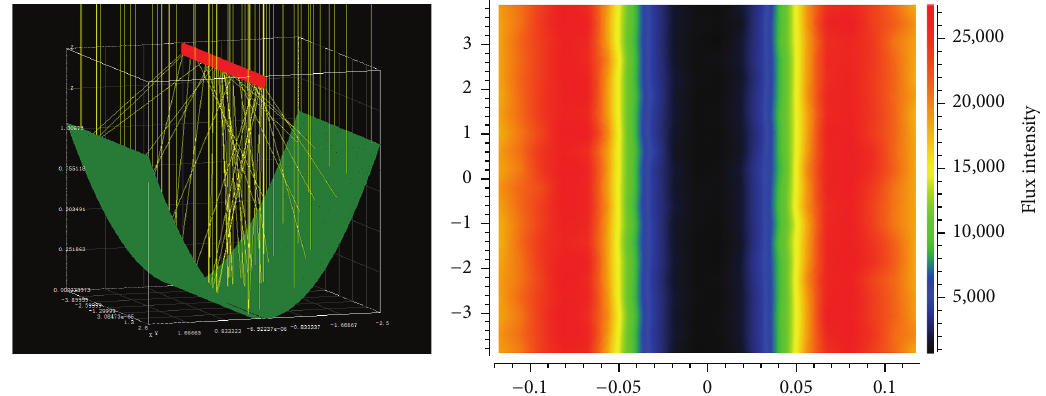
Figure 2: The simulation model and the heat density distribution of the LS-2 collector.